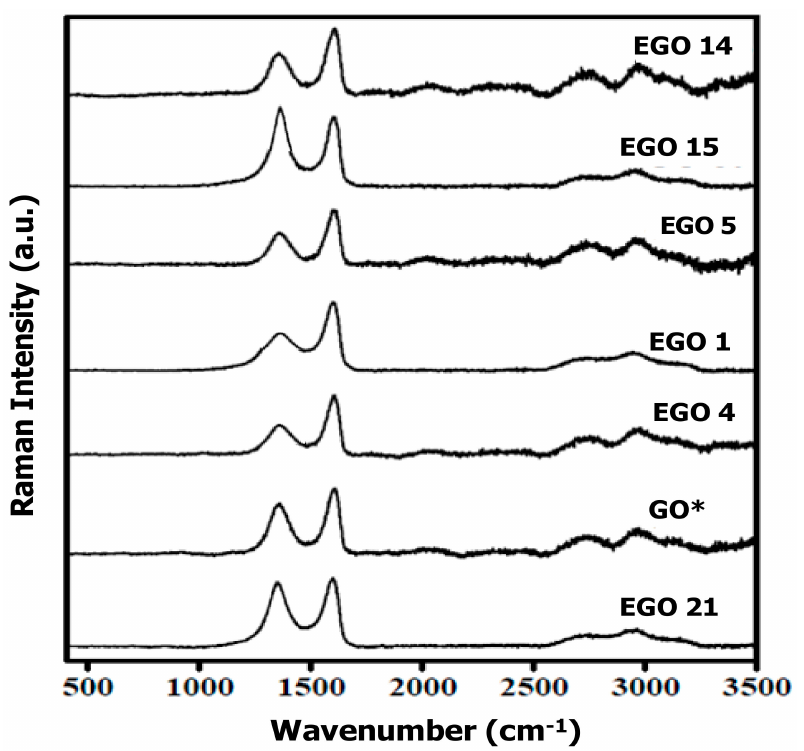
Figure 5. Raman spectra of the reference (GO*) and the indicated EGO